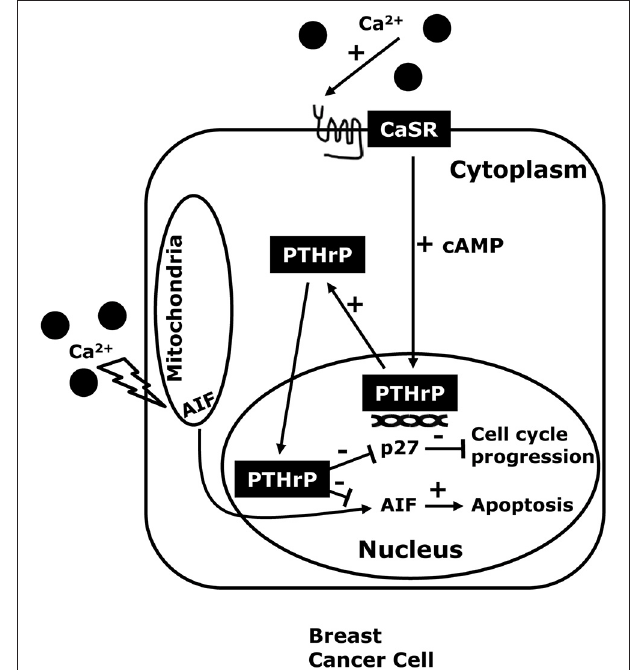
FIGURE 2 | The CaSR-nuclear PTHrP pathway. CaSR activation in breast cancer cells, stimulates PTHrP production through increased intracellular cAMP levels and also promotes the proliferation and inhibits cell death in high extracellular calcium concentrations. The effects of the CaSR on tumor cell growth appear to be mediated by nuclear actions of PTHrP that decrease expression of the cell cycle inhibitor p27 kip1 and that prevent nuclear accumulation of apoptosis-inducing factor (AIF) which activates apoptotic cell death.